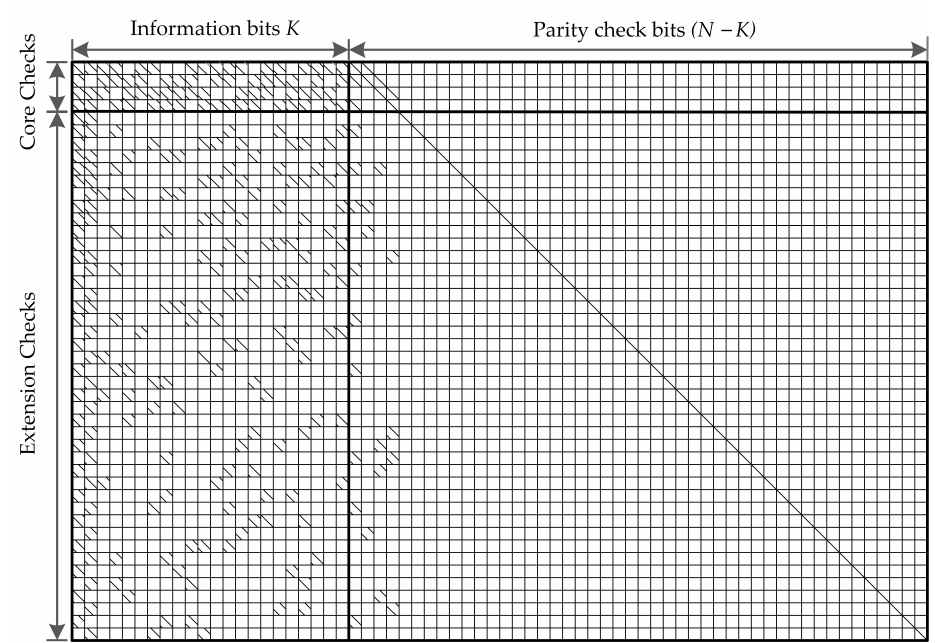
Figure 3. Schematic representation of base matrix base graph (BG)1 defined by 5G NR standard for